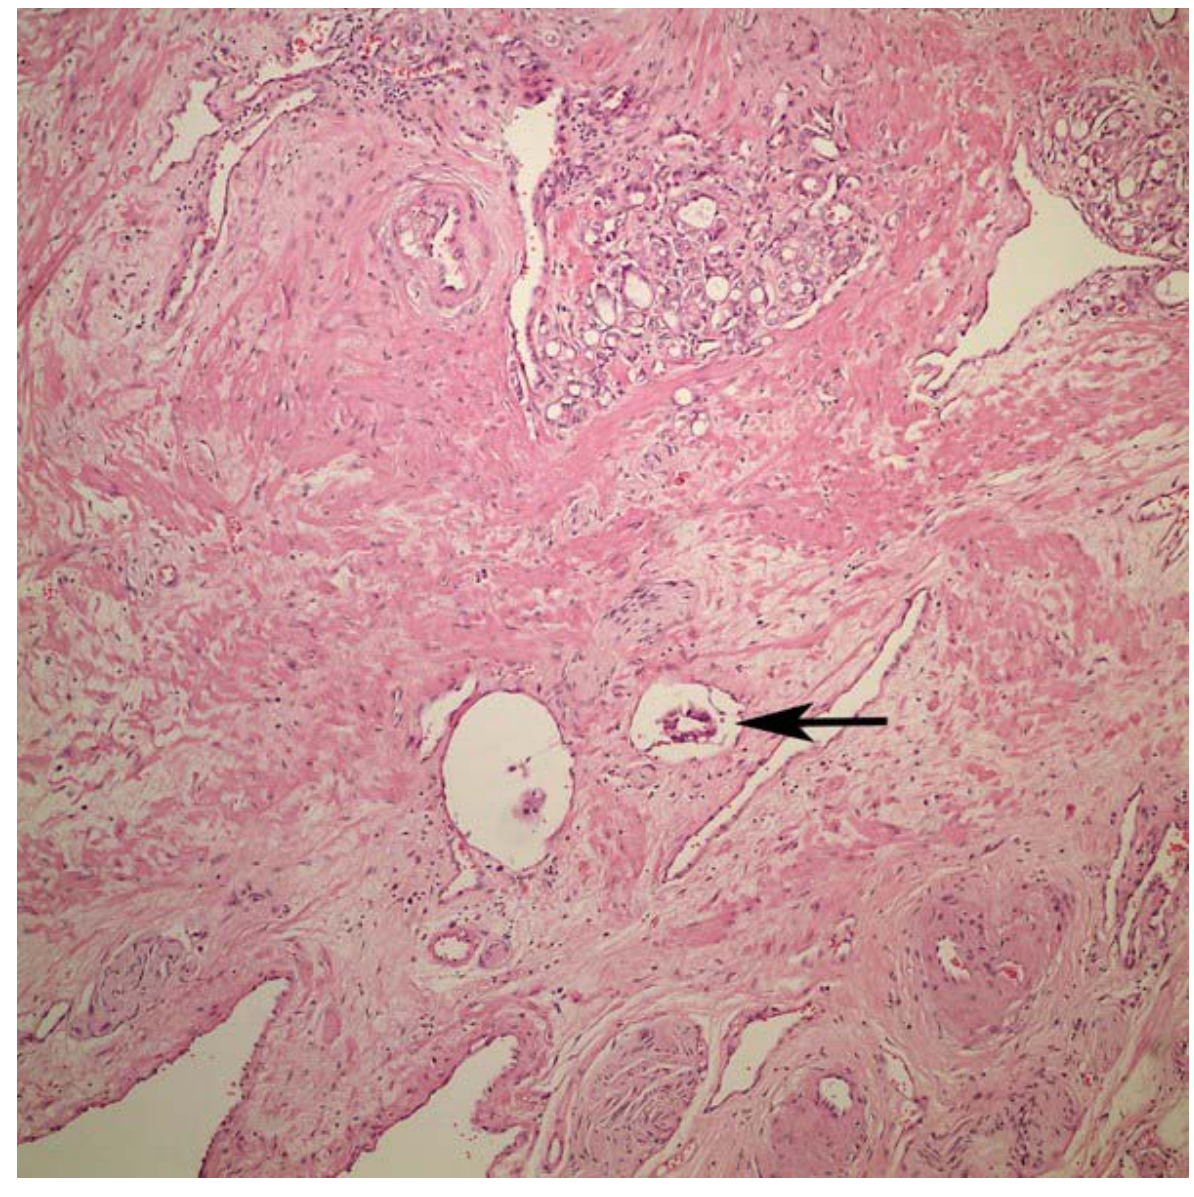
Among 11 patients with LVI, 10 had follow-up data. Nine out of 10 had recurrent disease (seven isolated biochemical failure, two local relapse, and one distant metastasis). LVI was the strong independent predictor for PSA failure in multivariant analysis when taken into account with grade, pT, lymph node involvement, age at diagnosis, preoperative PSA levels, and positive margins ( p = 0.023, logistic regression model). Gleason score was the other equally powerful independent variable of recurrence ( p = 0.023). In Cox regression analysis, LVI, pathological stage, and Gleason sum were the factors that determined the time to PSA failure (significance values 0.019, 0.027, and 0.049, respectively). The average time to biochemical PFS was significantly shorter for patients with LVI compared with patients without LVI (46.5 vs. 79 months, respectively). At 5 years, the PFS rate was 70% for patients without LVI, compared with 20% for patients with LVI (Fig.